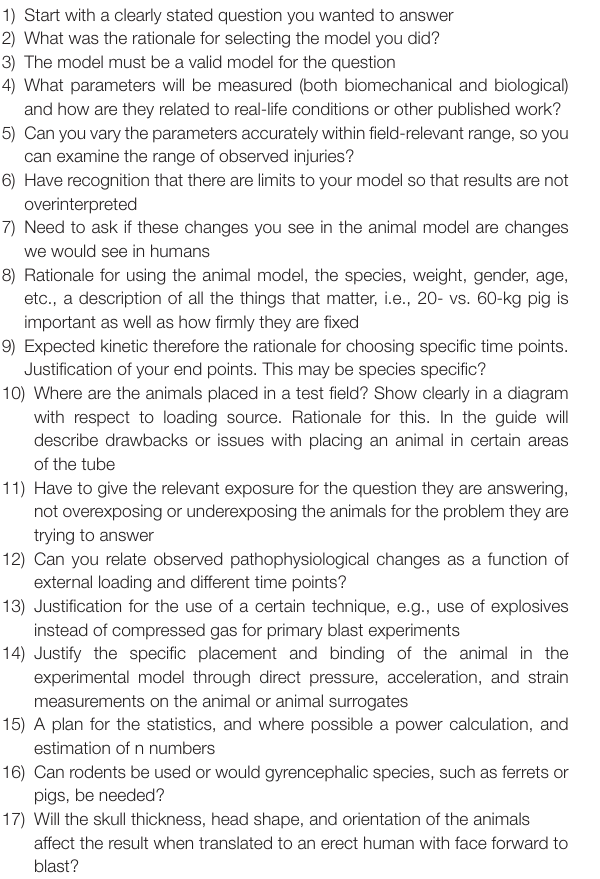
TABLE 3 | Checklist for experimental planning of preclinical blast